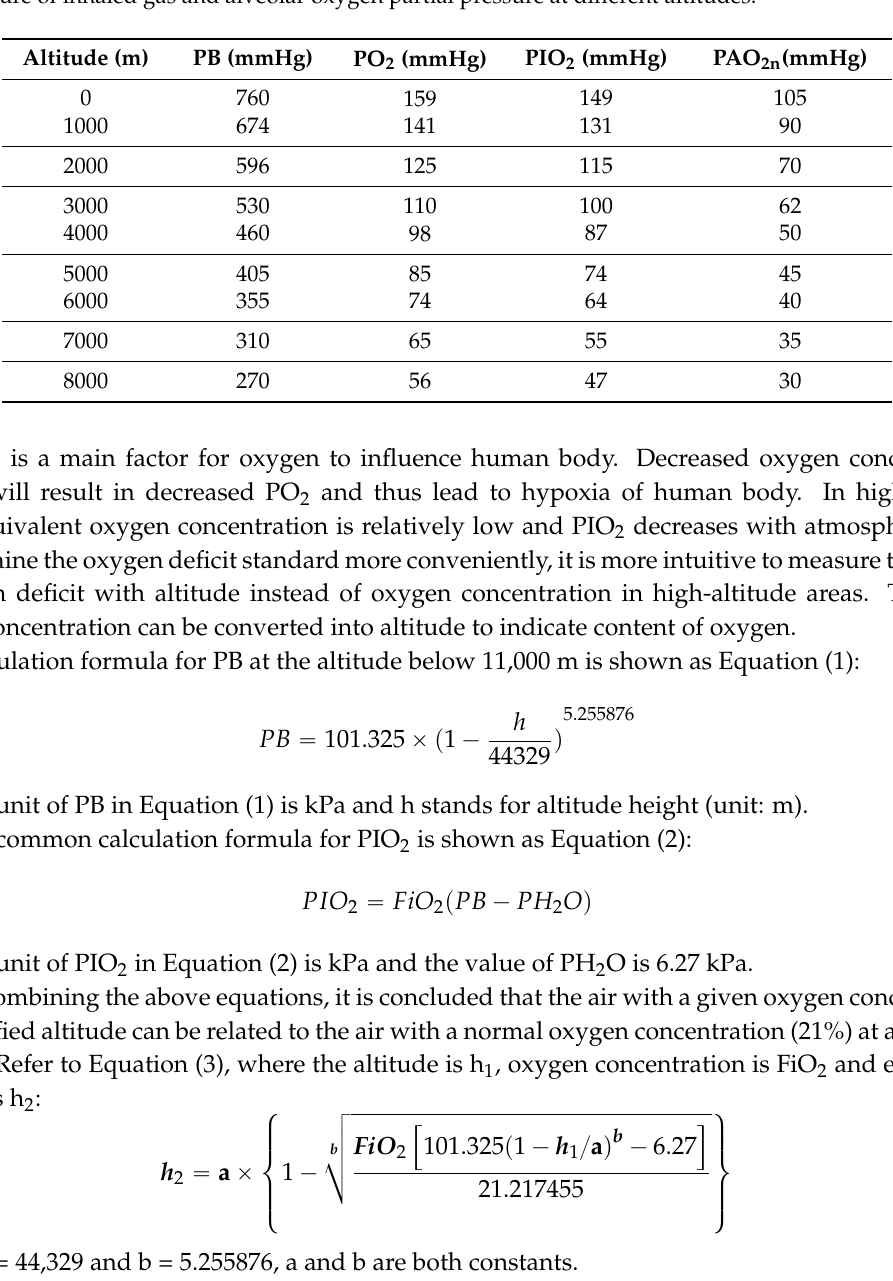
Table 4. Changes in atmospheric pressure, atmospheric oxygen partial pressure, oxygen partial pressure of inhaled gas and alveolar oxygen partial pressure at different